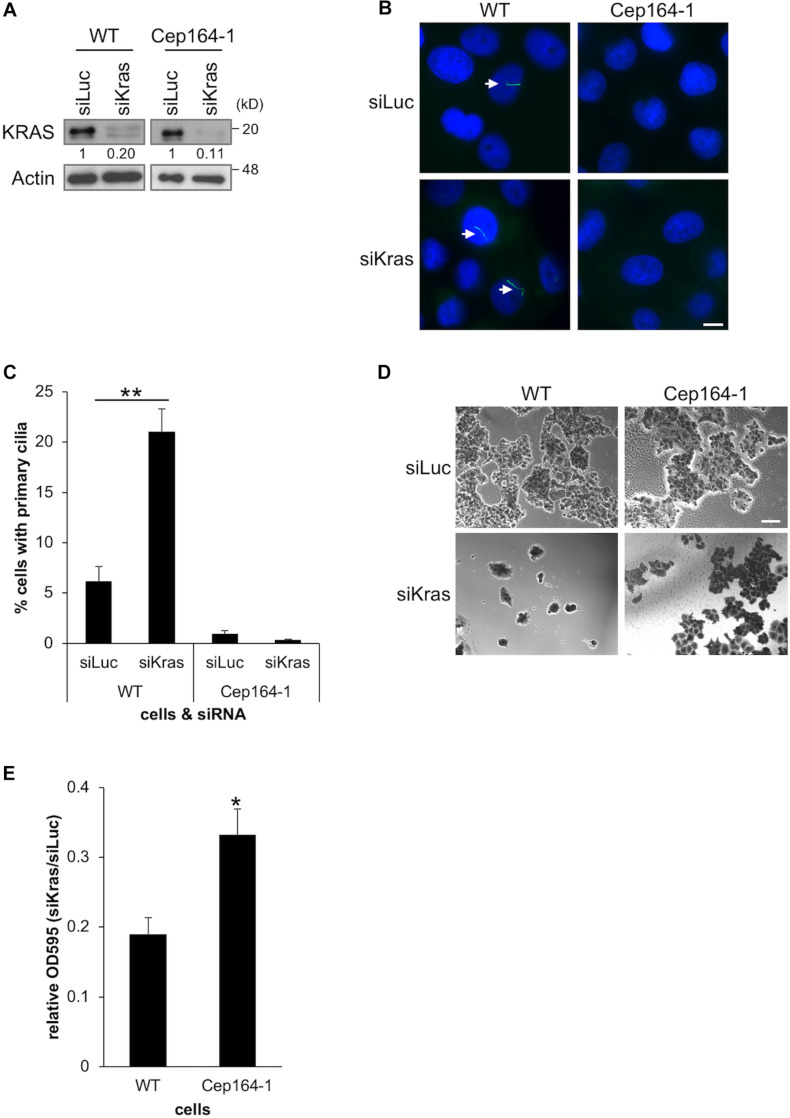
Cep164-1 cells are moderately tolerant to growth delay provoked by KRAS depletion. (A–E) The indicated cells transiently transfected with siLucifearase (Luc) or siKras were cultured for 5 days. (A) Cell extracts were immunoblotted with an anti-KRAS antibody. β-Actin was used as a loading control. The amount of indicated proteins was quantified using ImageJ, and the relative values are shown below the image. (B) Cells were immunostained with an anti-Arl13b (green) antibody. DNA was stained with Hoechst (blue). White arrows indicate primary cilia. Scale bar, 10 μm. (C) The percentage of ciliated cells was determined. The average of three independent experiments is shown; >200 cells were scored each time. (D) Cells were subjected to Crystal Violet assay. Representative images are shown. Scale bar, 100 μm. (E) The OD at 595 nm of dissolved cells was determined. The average of five independent experiments is shown. (C,E) All data are shown as mean ± SEM. **p < 0.01; *p < 0.05 compared with siLuc (C) or WT (E) (two-tailed Student’s t-test). Uncropped images of western blots are shown in Supplementary Figure 5.